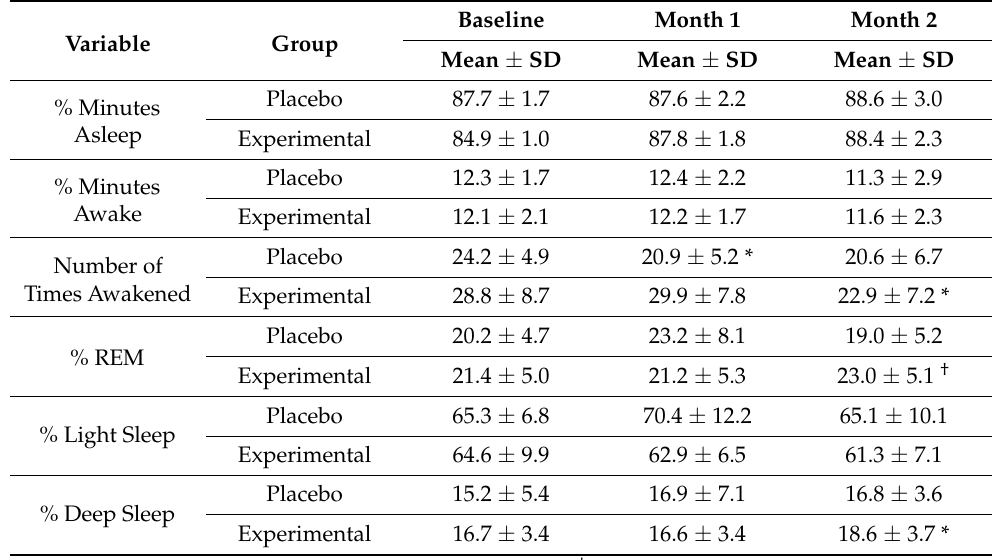
Table 8. Chart depicting Fitbit values in total population.